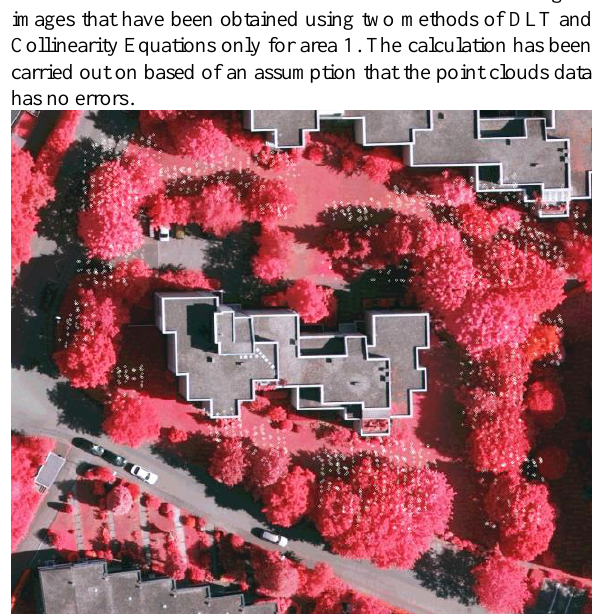
Figure 7: The miss match after registration of extracted trees from point cloud data onto the aerial